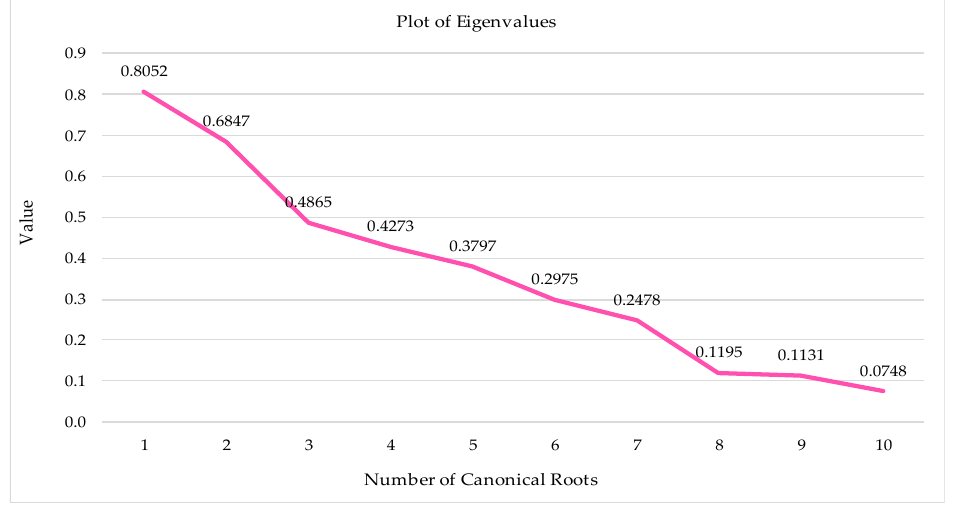
Table 2. Estimation of statistical significance of canonical correlations. Root Removed